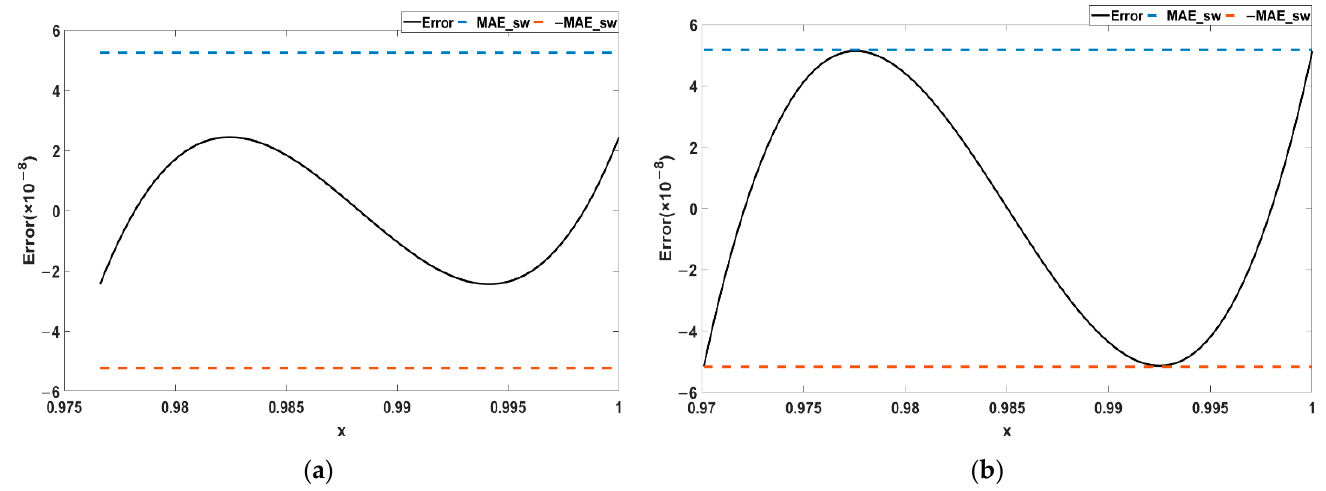
Figure 9. The impact of TF on the error distribution of the last segment. ( a ) The maximum absolute error of the last segment is not equal to MAE_sw; ( b ) the maximum absolute error in the last segment is equal to MAE_sw. Table 2. Impact of TF.